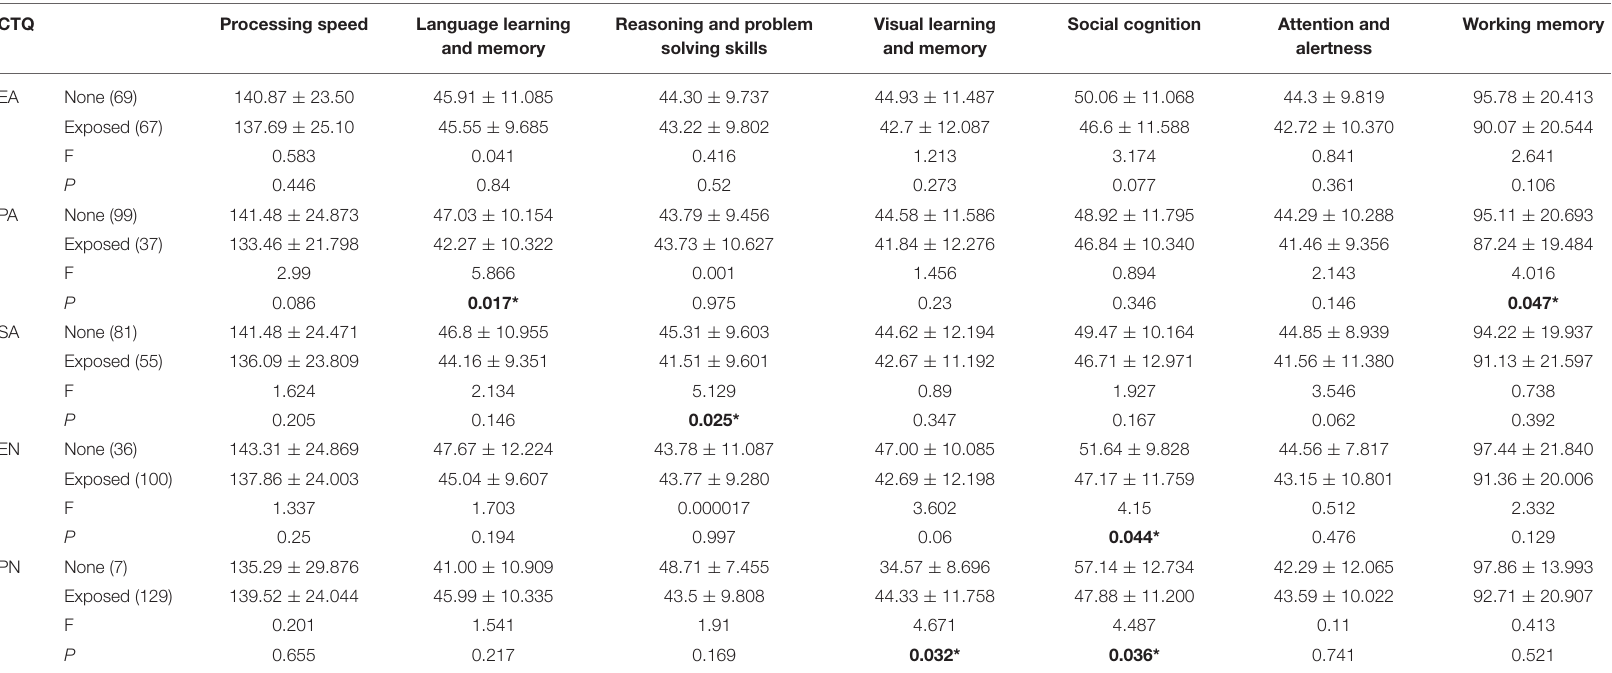
TABLE 5 | One-way analysis of variance of MCCB scores in terms of